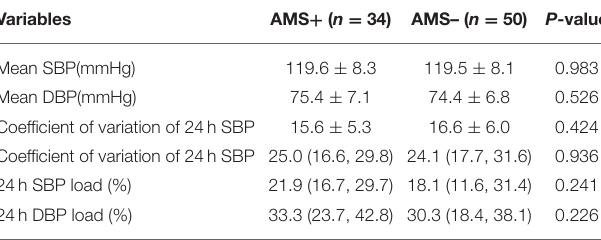
TABLE 3 | Comparison of ambulatory blood pressure examination at high altitude between two groups of